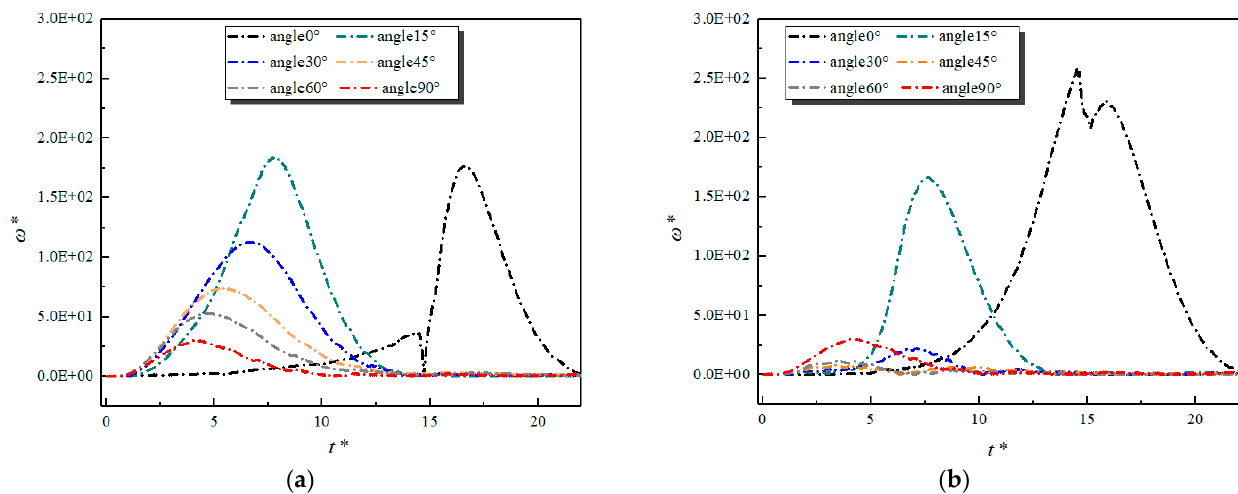
Figure 15. Particle’s dimensionless angular velocities as functions of dimensionless time. ( a ) Particle 1; ( b ) Particle 2.